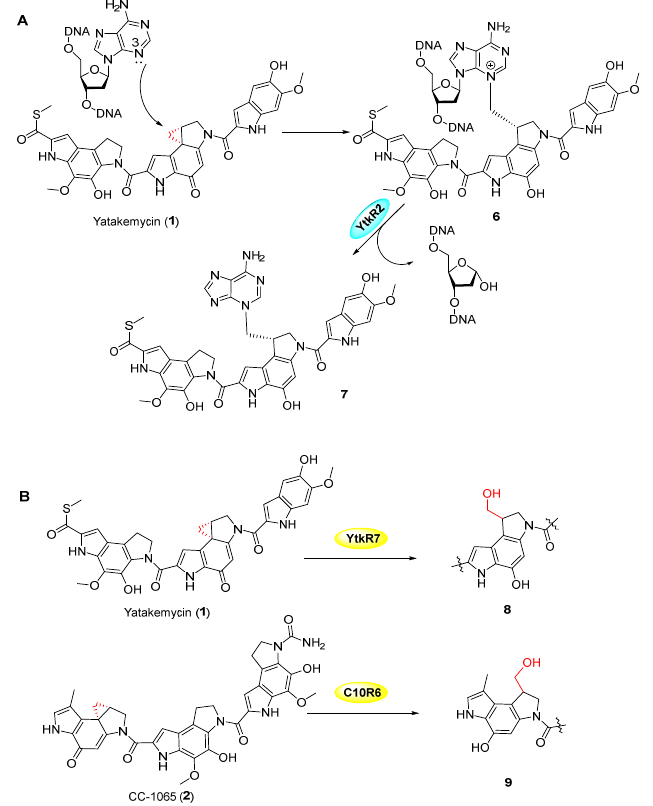
Figure 2. ( A ) DNA modification by YTM, and excision of DNA-drug complex by YtkR2. ( B ) Hydrol- ysis of the cyclopropyl moiety in YTM and CC-1065 by YtkR2 and C10R6, respectively.